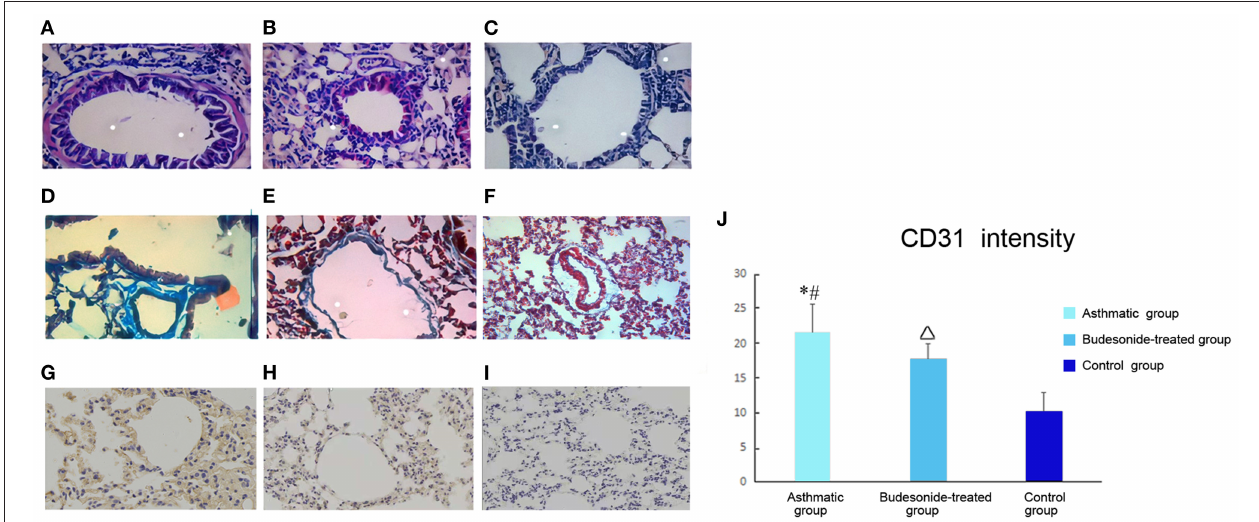
FIGURE 1 | Airway angiogenesis aggravated in asthma. (A–C) Bronchial hyperplasia in asthma (HE staining). (A) The asthmatic group, (B) the budesonide-treated group, (C) the normal control group. Magnification, × 400. Bronchial hyperplasia was observed using HE staining. (A) Damaged tracheal structures and infiltration of the inflammatory cells were observed in the asthmatic group (mean rank: 27.05). (B) Damaged tracheal structures and infiltration of inflammatory cells were alleviated in the budesonide-treated group (mean rank: 17.73). (C) Relatively complete bronchial structures were in the normal control group (mean rank: 6.23). (D–F) Increased collagen deposition in asthma using Masson staining. (D) The asthmatic group, (E) the budesonide-treated group, (F) the normal control group. Magnification, × 400. Increased collagen deposition in lung tissues was determined using Masson staining. (D) Substantial collagen deposition was observed in the interstitium of the asthmatic mice (mean rank: 19.83). (E) Collagen deposition was reduced in the budesonide-treated group (mean rank: 15.67). (F) Little collagen deposition in interstitium was observed in the control group (mean rank: 6.50). (G–J) Expression of CD31 in lung tissues. (G) The asthmatic group, (H) the budesonide-treated group, (I) the normal control group. Magnification, × 200. (J) CD31 intensity in lung tissues. Expression of CD31 protein in lung tissues was investigated using immunohistochemistry. Vessel area was increased in the asthmatic group compared with that in the control group and decreased in the budesonide- treated group. * P < 0.01, the asthmatic group vs. the normal control group. # P < 0.01 the asthmatic group vs. the budesonide-treated group. N P < 0.01, the budesonide-treated group vs. the normal control